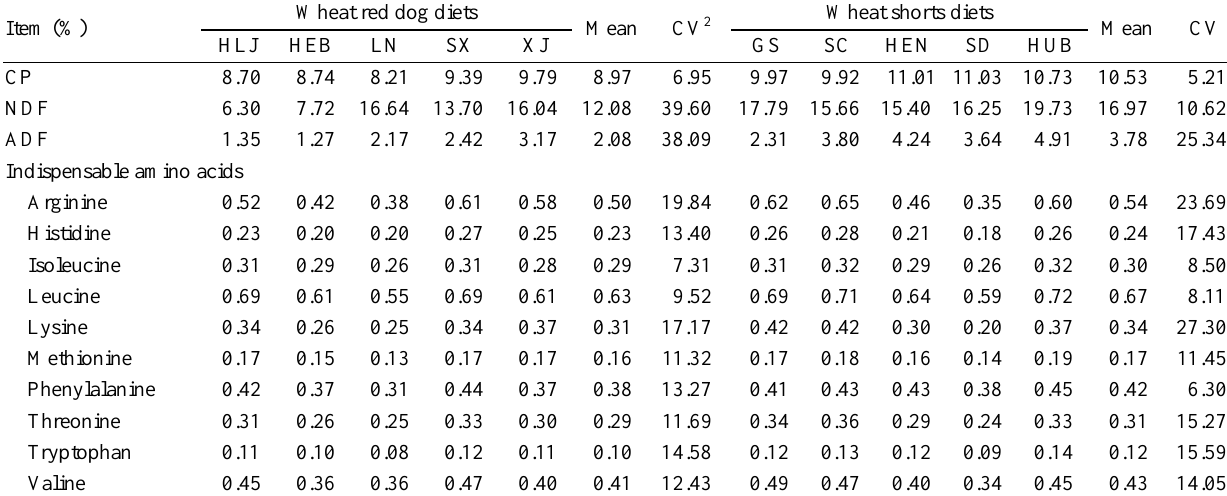
Table 8. Analyzed composition of experimental diets used in Exp. 2 (% DM) Wheat red dog diets Item (%)